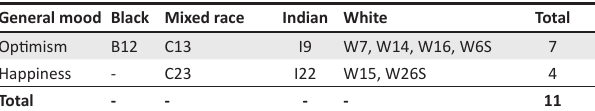
TABLE 5: General mood. General mood Black Mixed